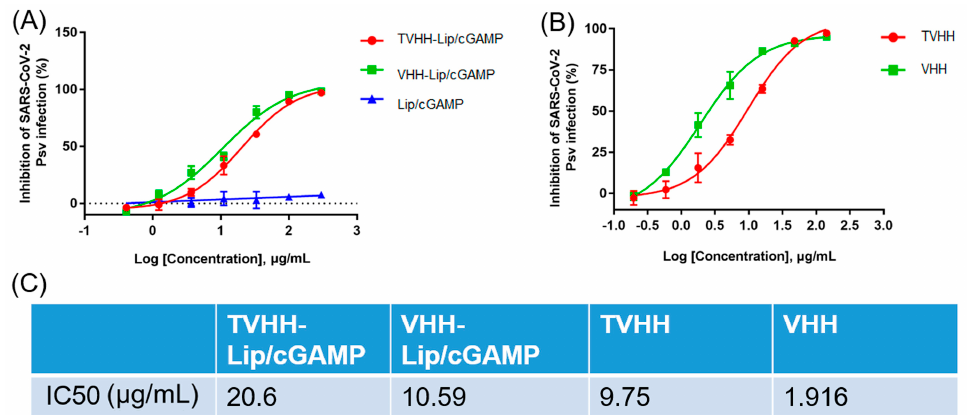
Figure 2. Neutralization activities of immunoliposomes ( A ) and nanobodies ( B ). The IC50 values ( C ) of the neutralization.